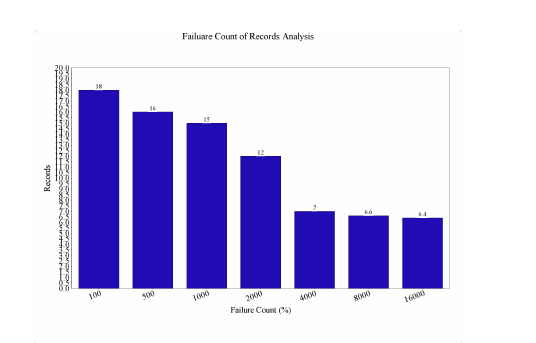
Figure 7. Failure count Analysis of posposed ETL model while increasing number of records